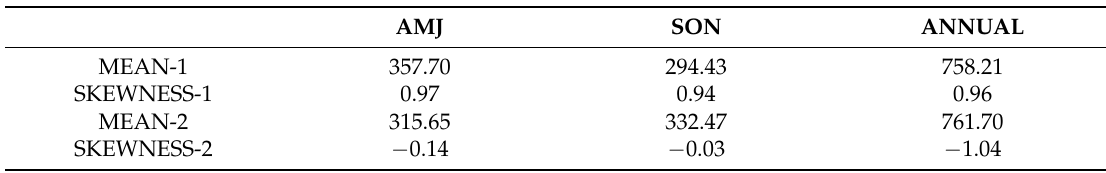
Table 1. Changes in the statistics of the rainfall (Index 1 indicates the period 1952–1983, while Index 2 is for the period 1984–2014).